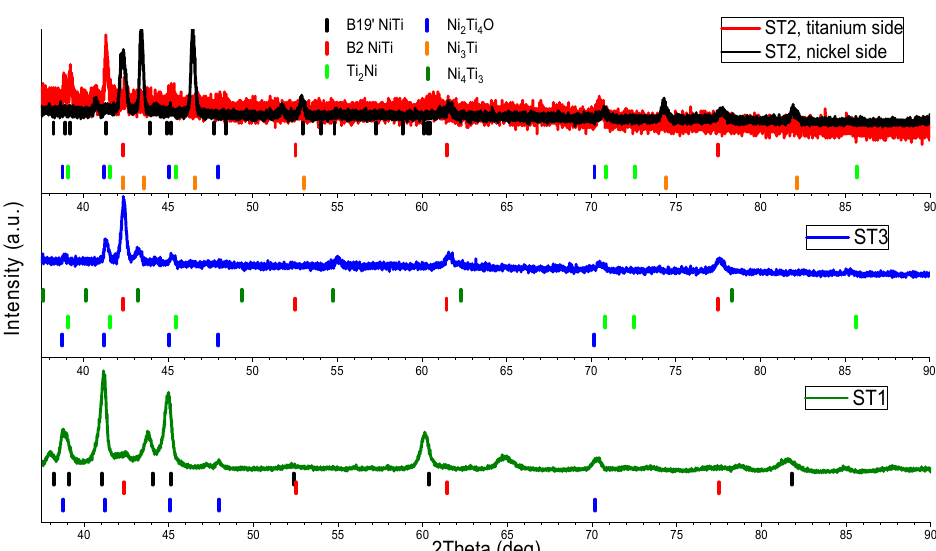
Figure 1. X-ray diffraction patterns at ambient temperature for the sample: ST2, ST3, and ST1. Phases’ structural peaks are respectively marked.